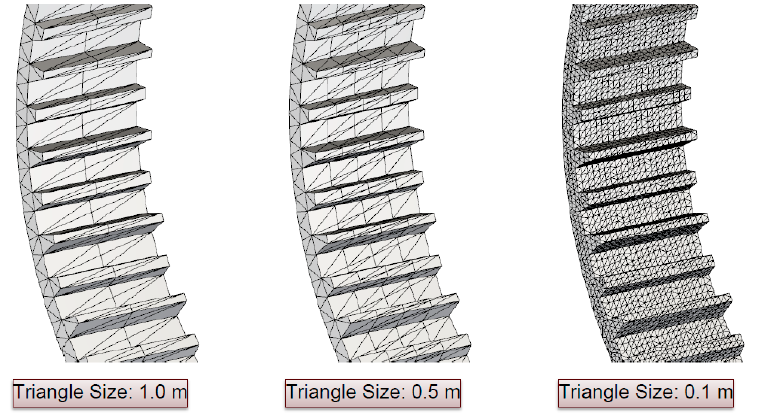
Figure 6. Boundary definition for the geometrical mesh of the wear parts [29]